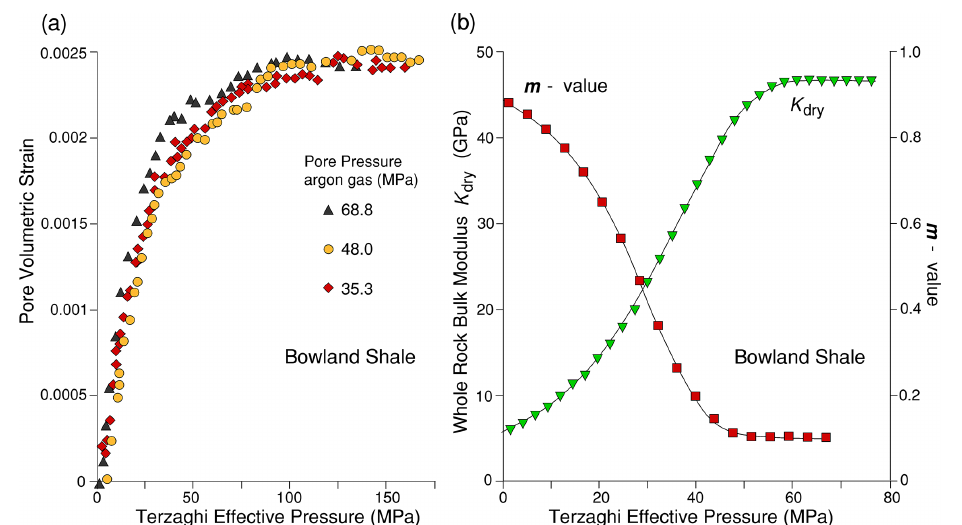
Figure 9. (a) Pore volumometry of Bowland shale at 34.5, 48, and 69MPa gas pore pressure. There is no significant difference at the three pore pressures, so that a single polynomial function can be fitted to all the data. The slope of the curves corresponds to the pore compressibility, which decreases markedly with increasing effective pressure. (b) Calculated K dry bulk modulus of the sample (pore pressure = 69MPa) from pore volumometry measurements (inverted triangle symbols). K o = 52 . 8MPa. Also plotted is the m value from pore volumometry (square symbols) for Bowland shale at 69MPa pore